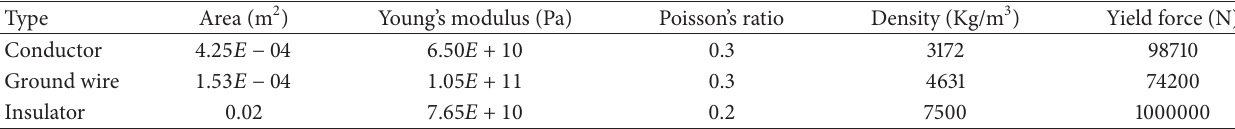
Table 2: Properties and performance indices of conductor, ground wire, and